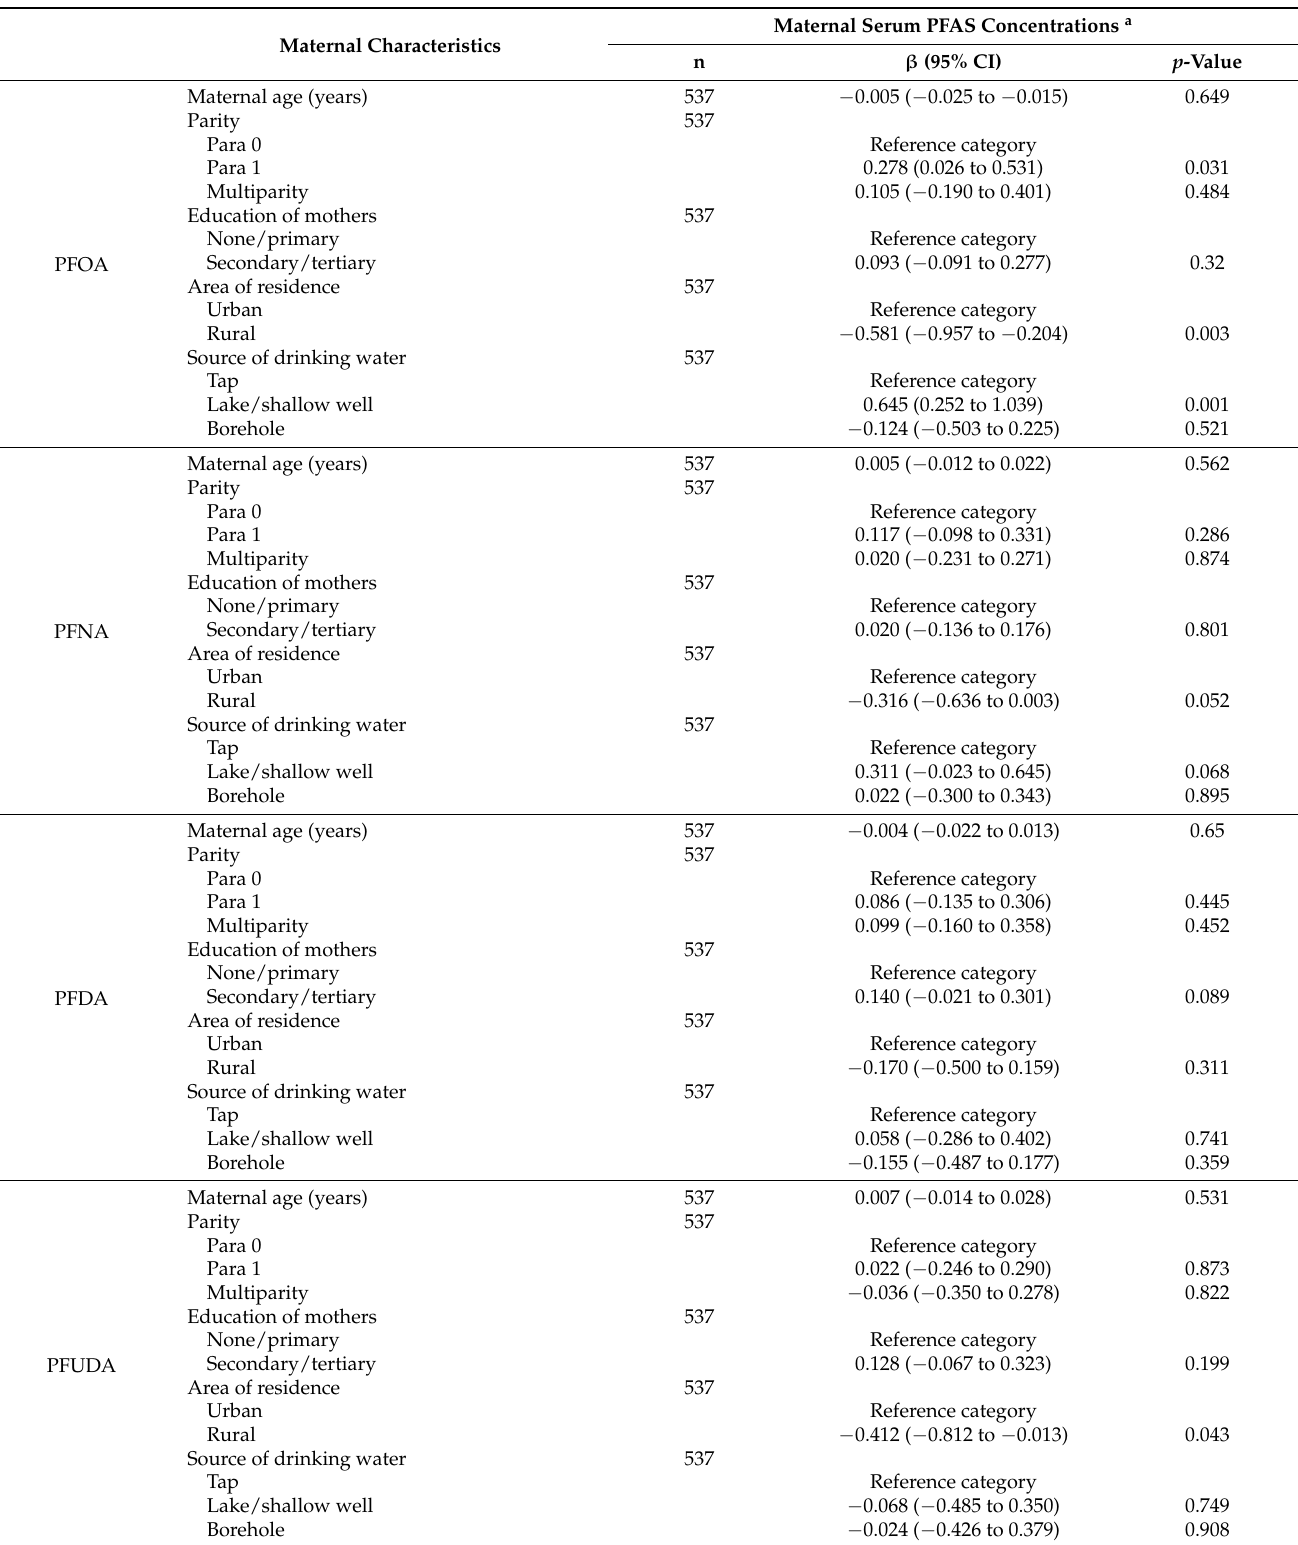
Table 3. Multivariable linear regression of PFAS concentrations in blood serum and maternal